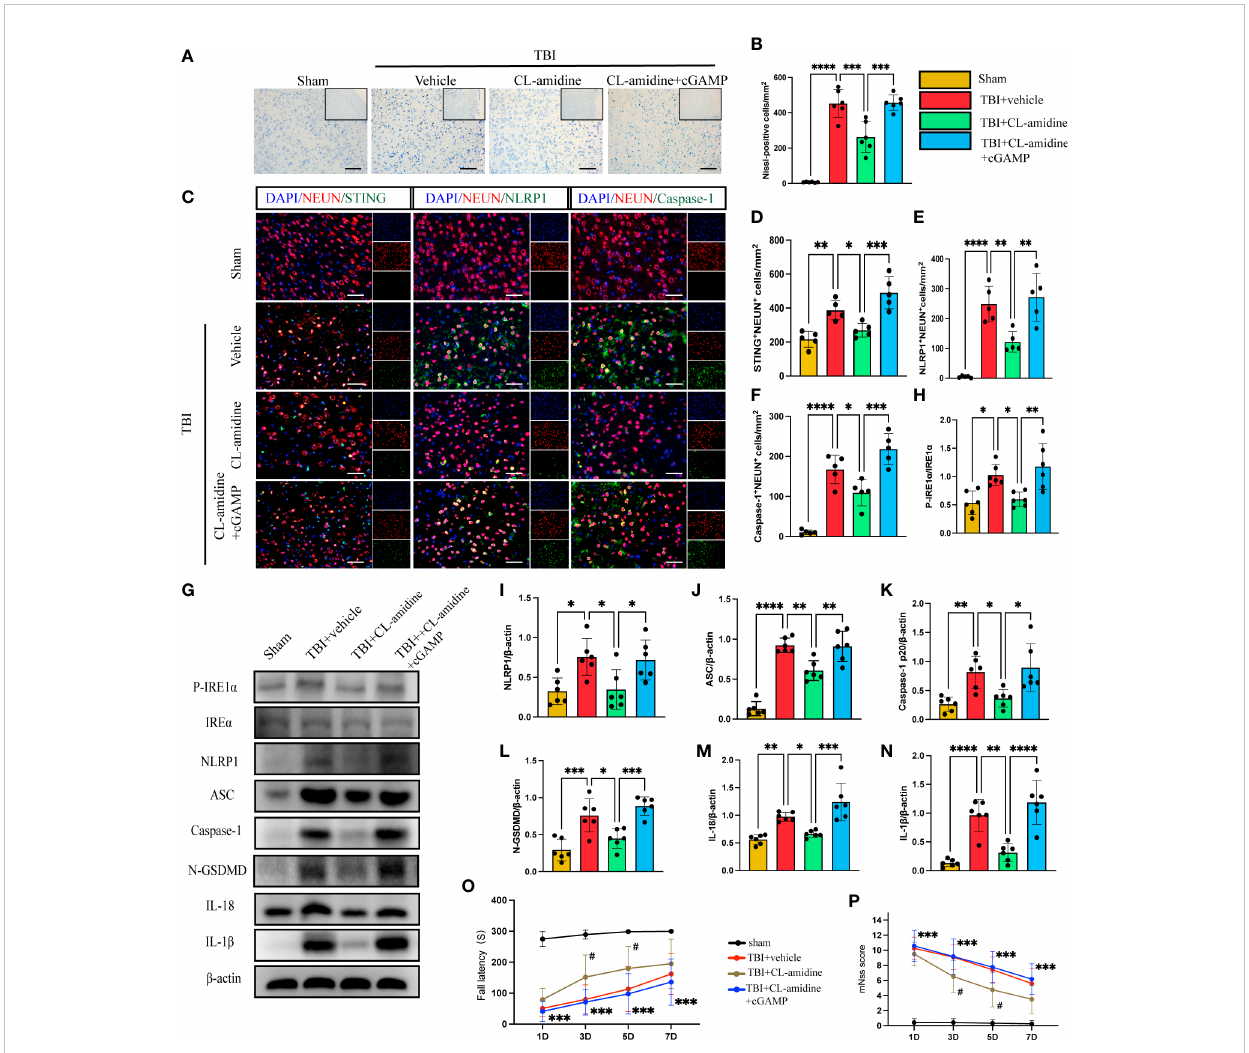
FIGURE 5 Inhibition of PAD4 ameliorates neurons ’ pyroptosis by inhibiting the STING-IRE1 a -NLRP1 pathway. (A) Nissl staining images of the peri-injured brain tissue of mice. Count the number of Nissl-positive cells in the different groups (B) . Scale bar = 100 m m. (C) Representative fl uorescent double stain images of NEUN-positive neurons with STING-positive cells (green), NLRP1-positive cells (green) and Caspase-1-positive cells (green)in the peritraumatic cortex(n=5). Nuclei were stained with DAPI (blue). Scale bar = 50 m m. Count and analyze the number of double-stained positive cells of NEUN-positive neurons with STING-positive cells (D) , NLRP1-positive cells (E) and Caspase-1-positive cells (F) in the different groups.